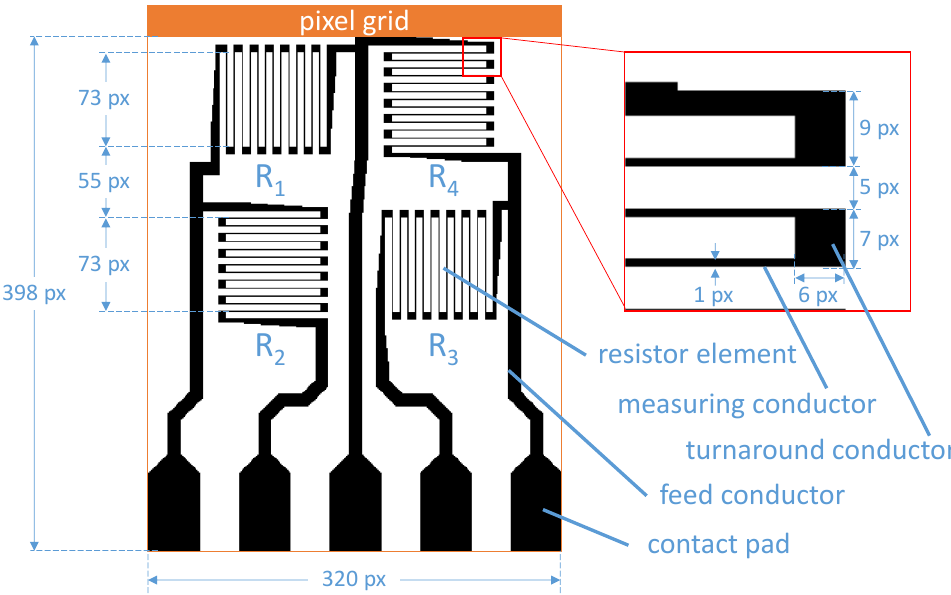
Figure 2. The print pattern contains a SG full bridge with two perpendicular line orientations with four resistive elements and five contact pads.